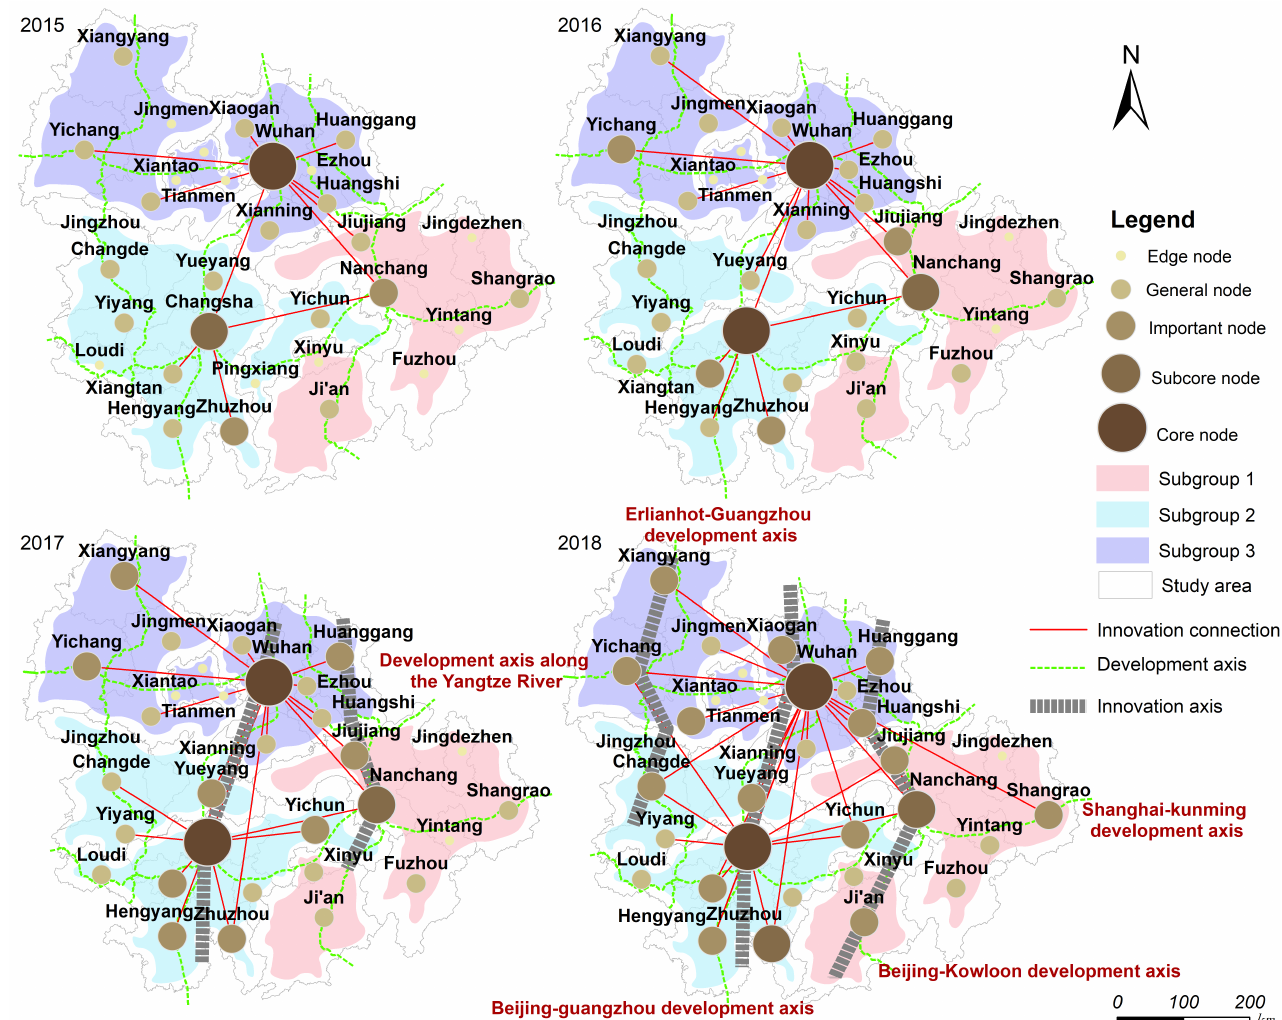
Figure 8. Evolution of innovation patterns in the UAMRYR from 2015 to 2018 is based on the centrality of cities, the intensity of innovation links between cities, and the division results of cohesive subgroups. The status of cities in the innovation network is divided according to the centrality of cities.